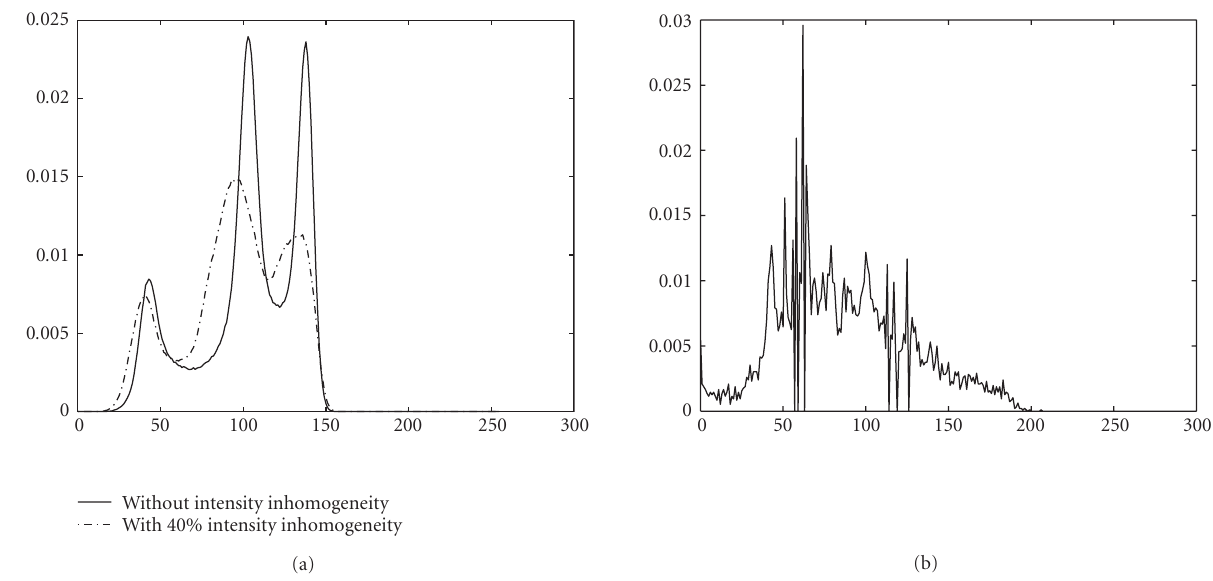
Figure 3: Histogram of brain tissue with the presence of intensity inhomogeneity. (a) Corresponds to a BrainWeb-simulated image: without intensity inhomogeneity (solid line) and with 40% intensity inhomogeneity (dashed-dotted line), and on (b) the head image (Figure